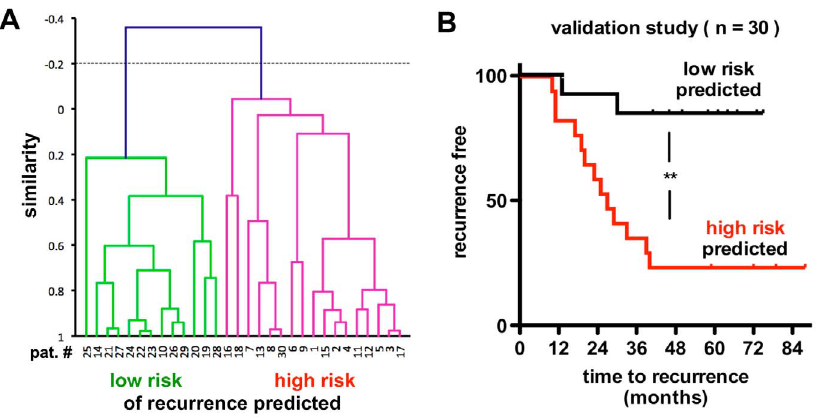
Figure 5. Disease recurrence in patients relative to their risk predicted from the serum levels of miRs. A, Hierarchical clustering of patients from the validation study into low and high risk groups based on serum miR levels. The analysis resulted in a separation into two groups. B , Kaplan-Meier plot of patients predicted to have high and low risk of disease recurrence. The comparison resulted in P=0.0026, Hazard Ratio 5.4 (1.9 to 15.0 95% CI). In panel A patients with disease recurrence are # 1 to # 15 and without recurrence: # 16 to # 30.